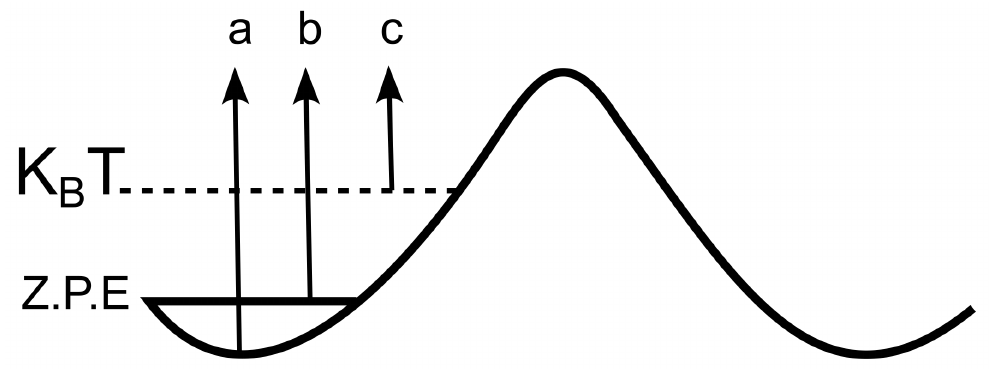
Figure 2. The effect of zero-point energy and temperature on the MAE of an arbitrary barrier. The energy of the electronic state of the system is increased such that the bottom of the potential well is no longer accessible, leading to a decrease in the effective barrier, which change the MAE from being represented by arrow a to arrow b. Increasing the temperature will lead to arrow